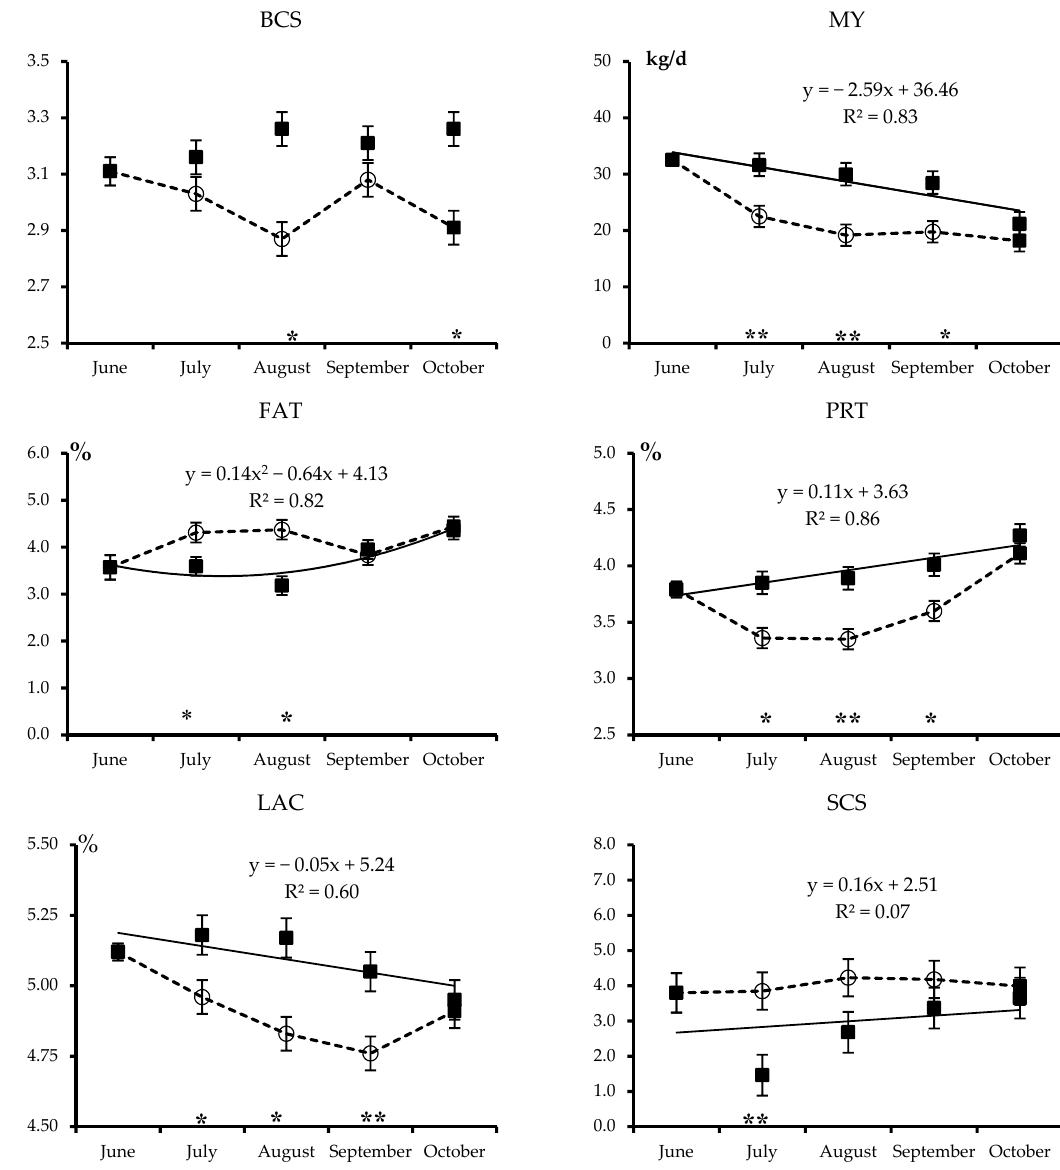
Figure 1. Least squares means and standard error of the combined Treatment × Month effect for body condition score (BCS) and milk traits (MY: Milk yield, FAT: Content of milk fat, PRT: Milk protein, LAC: Milk lactose, SCS: Somatic cell score) of Brown Swiss cows kept on the permanent farm ( ■ and continuous line) or moved to highland summer pasture from July to September ( ○ and dotted lines).